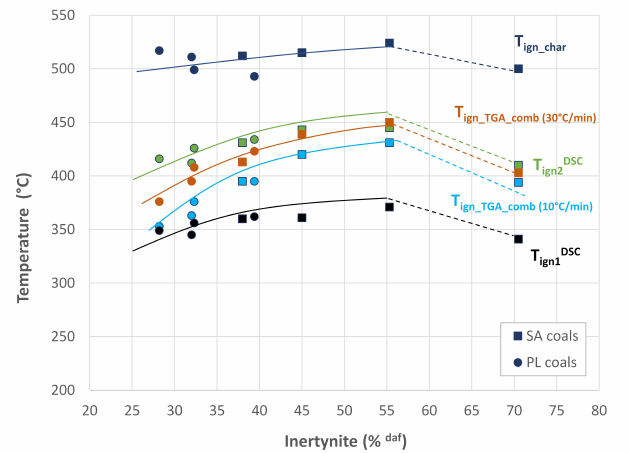
Figure 2. Effect of inertinite content of coals on the TGA/DSC ignition temperature, T TGA (10 ◦ C/min; 30 ◦ C/min), T DSC